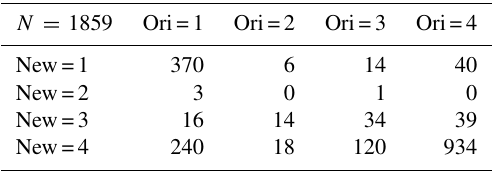
Table 6. Confusion matrix for P168, O092981, B102, camera DA. N =